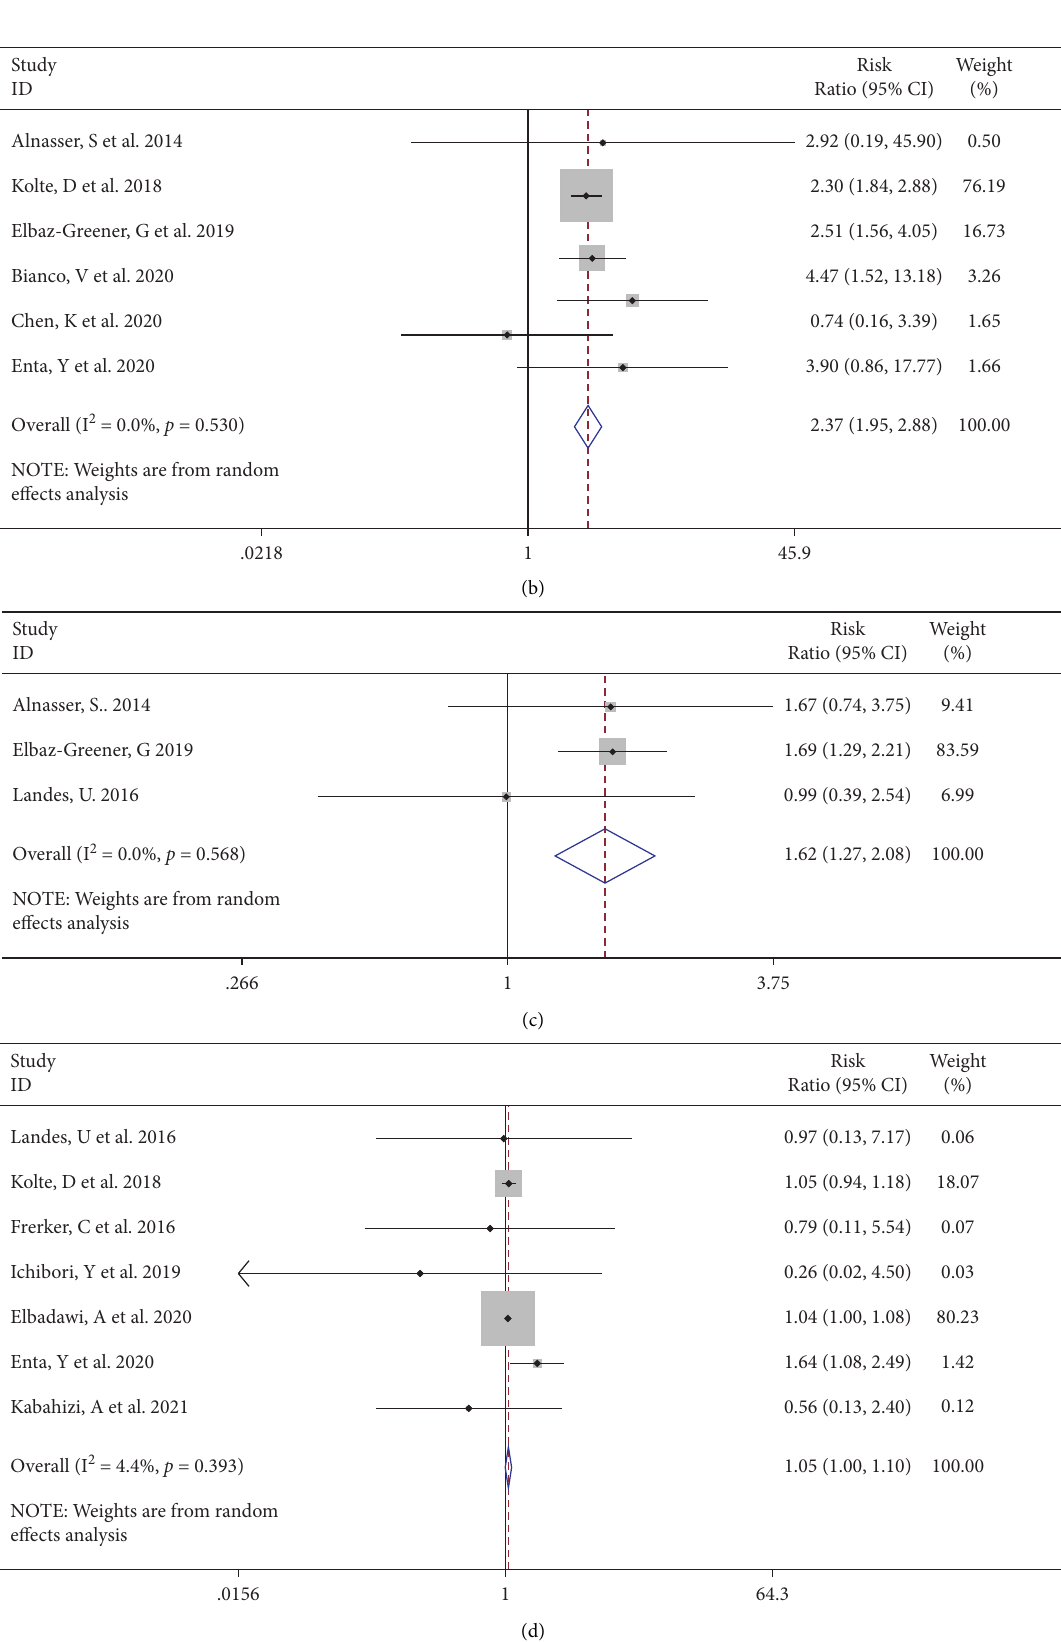
Figure 5: Forest plot showing the incidence of AKI (a), dialysis (b), bleeding (c), and major bleeding (d) increased in the emergent TAVI group. CI, confidence